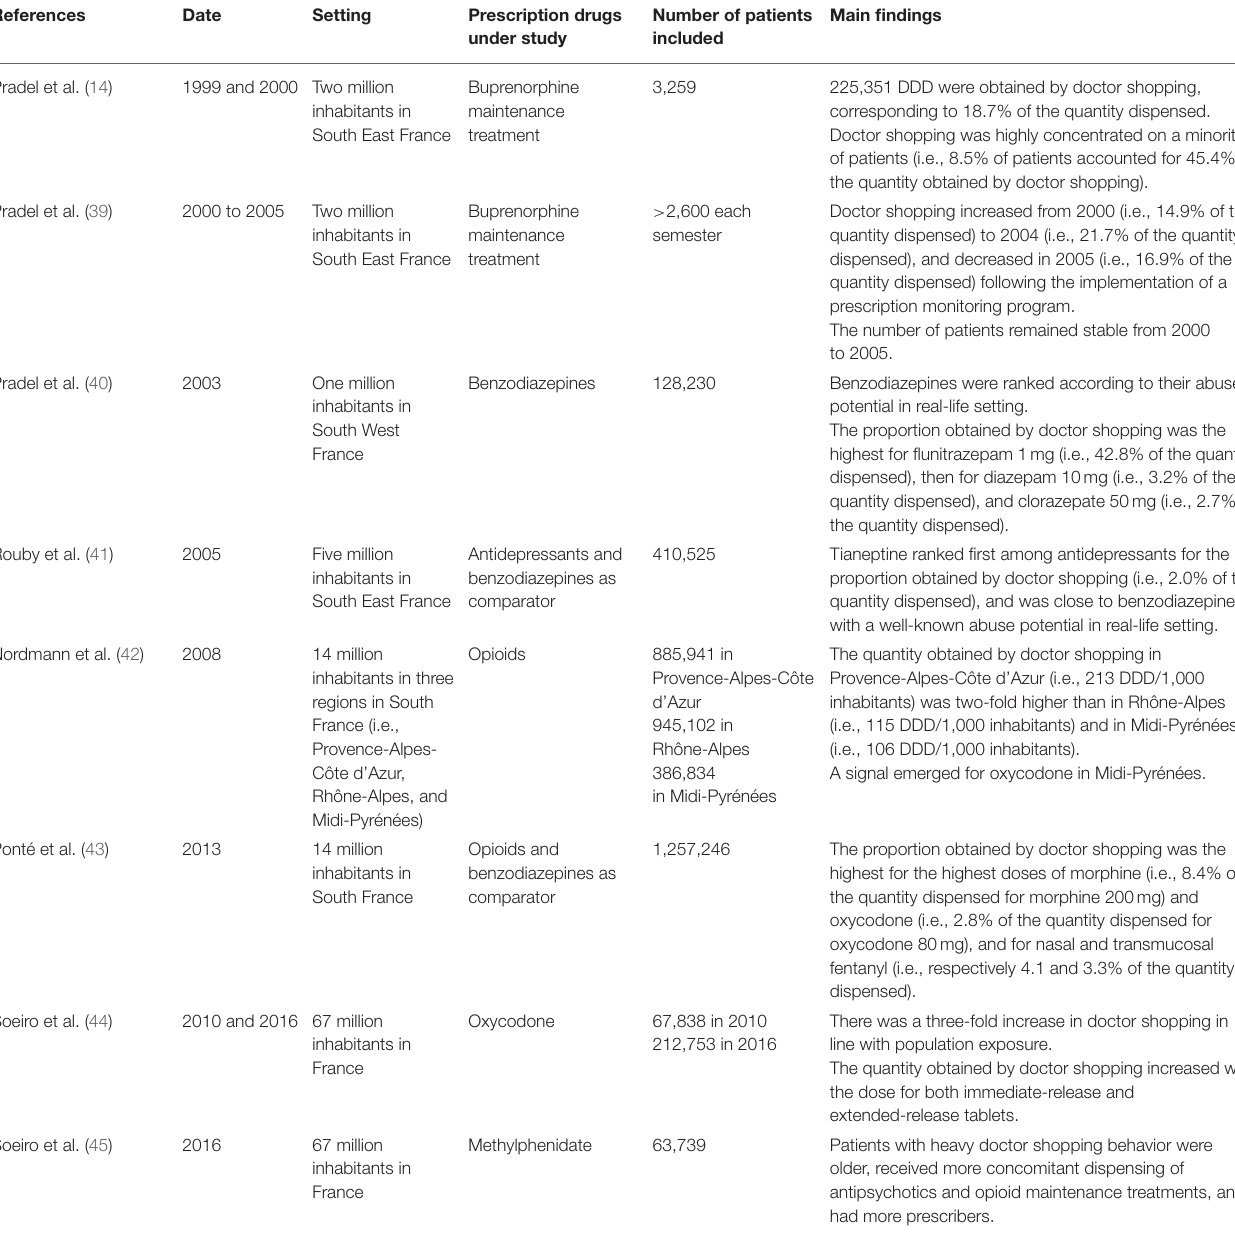
TABLE 1 | Empirical validation of the method accounting for overlapping prescription, in the last two decades, in